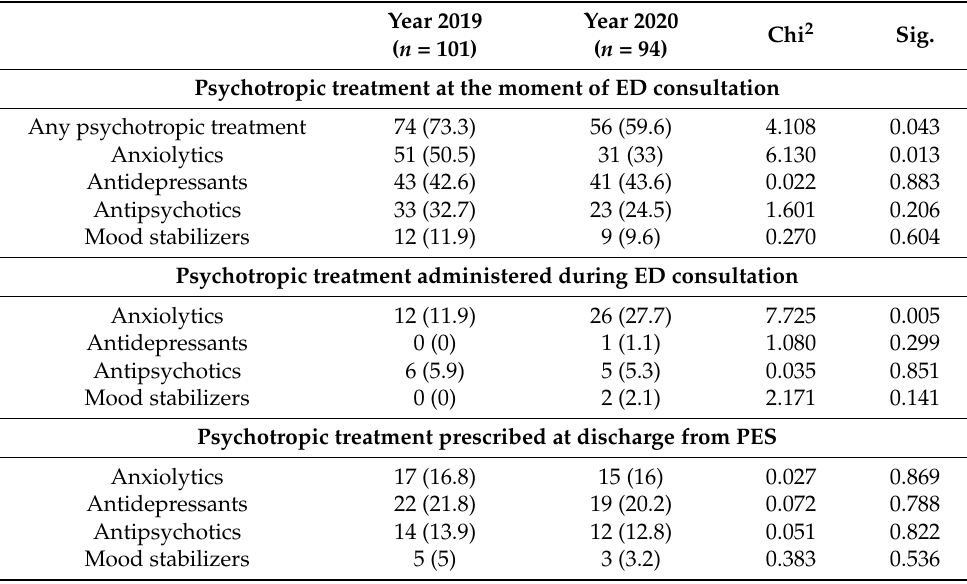
Table 3. Treatment characteristics of the study